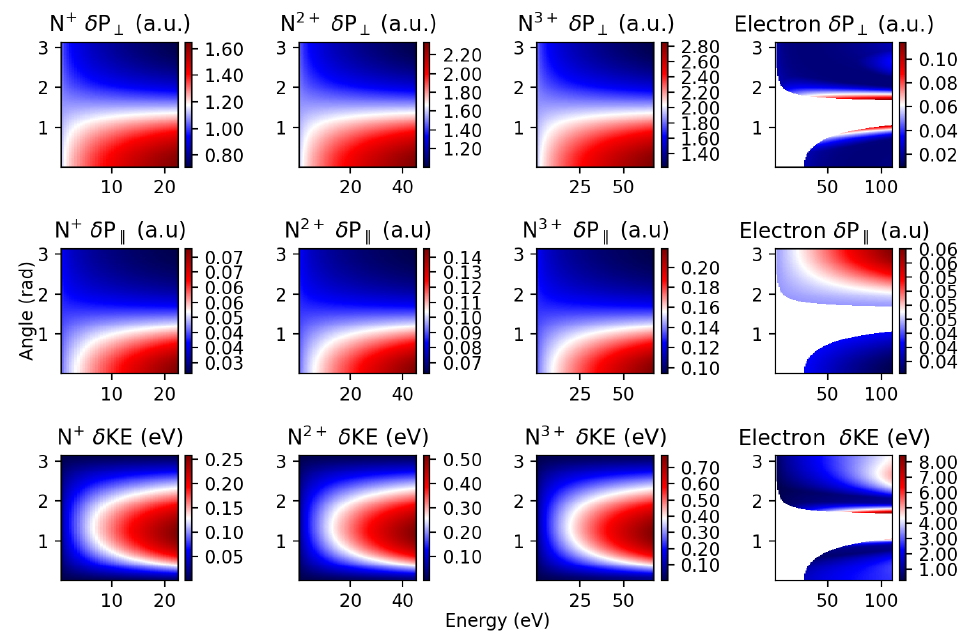
Figure 11. Ion and electron momentum and energy resolution with the spectrometer setting as defined in Figure